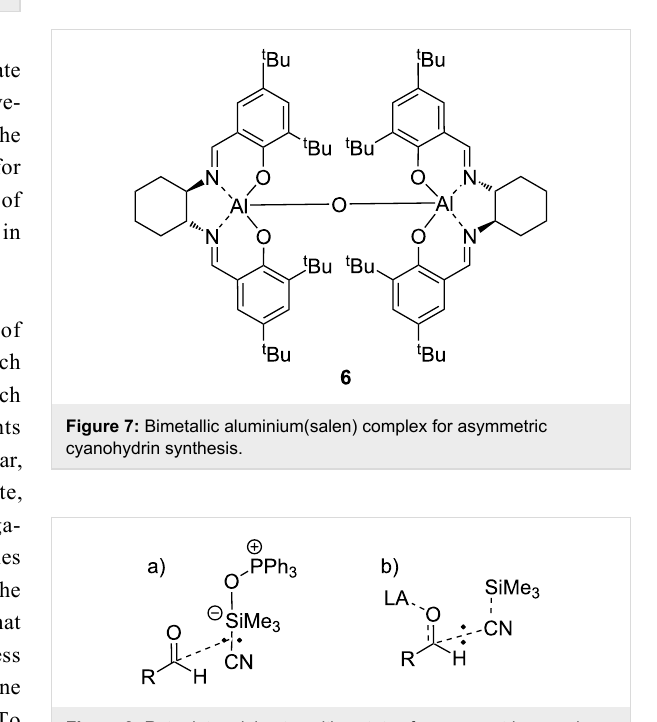
Figure 8: Rate determining transition states for asymmetric cyanohy- drin synthesis: a) when Lewis base catalysis is dominant; and b) when Lewis acid catalysis is